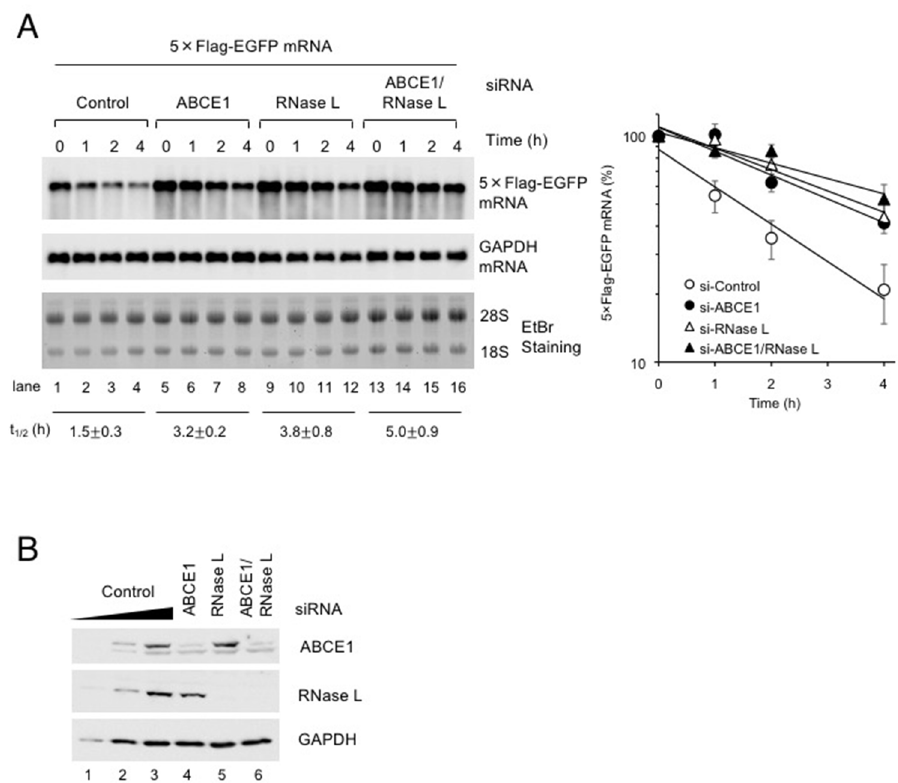
Figure 2. ABCE1 and RNase L act together to eliminate exogenous RNA. ( A ) ABCE1 and RNase L were depleted in HeLa cells by using siRNA. Following depletion of ABCE1 and/or RNase L, the cells were further transfected with 5×Flag-EGFP mRNA for 1 h and cultured in growth medium over time. 5×Flag-EGFP mRNA and GAPDH mRNA were analyzed by northern blotting. The leftmost five lanes analyzed two-fold dilutions of total RNA as standard curve. The levels of 5×Flag-EGFP mRNA were normalized to the levels of GAPDH mRNA to depict the decay rate (mean ± SEM, n = 3) and to calculate the half-lives (average t 1/2 ± SEM, n = 3). ( B ) The levels of ABCE1 and RNase L in ( A ) were determined by western blotting ( n = 3).